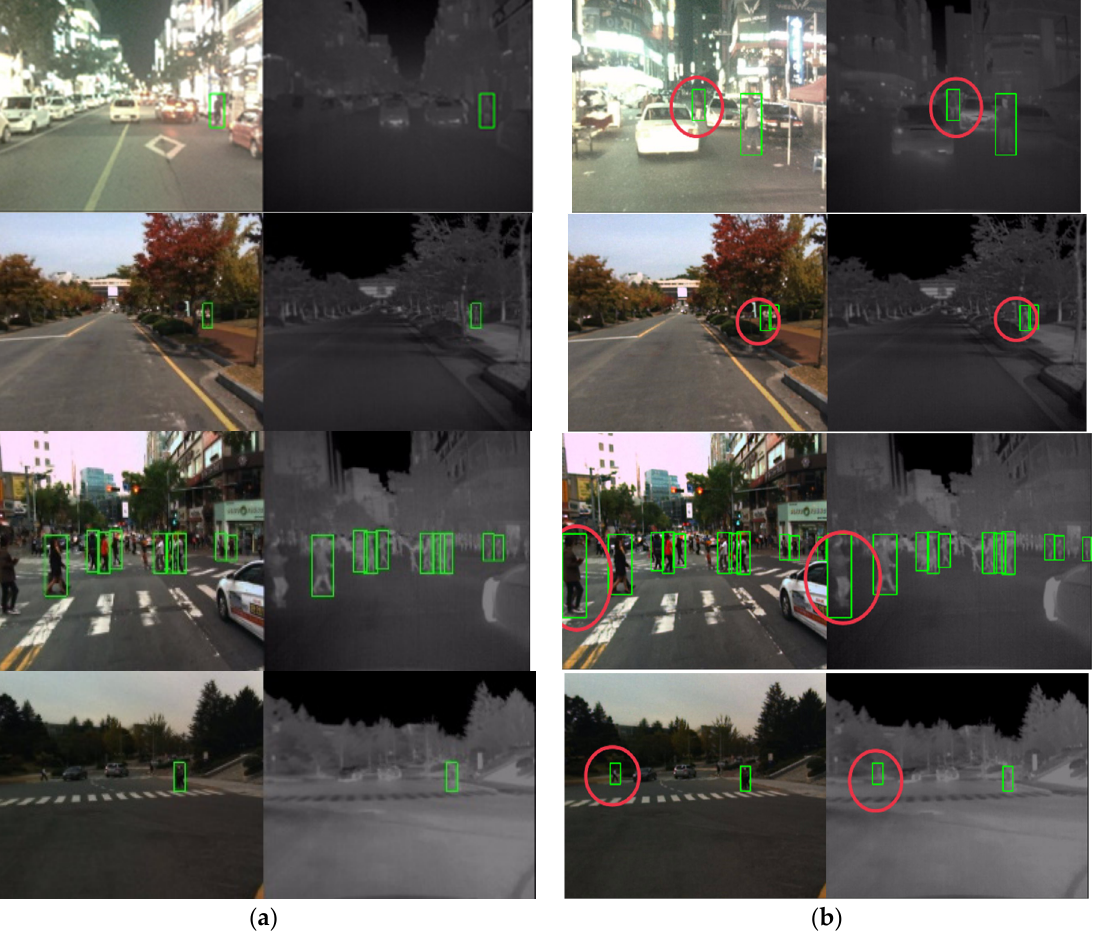
Figure 6. Visualization of MBNet ( a ) and the proposed RISNet ( b ) detection results on the KAIST dataset. The first row shows the detection results in the night scenarios. The second row shows the detection results in the daytime scenarios. The third row shows the detection results in the near scenarios. The fourth row shows the detection results in the far scenarios. Targets circled in red represent targets not detected by MBNet but detected by